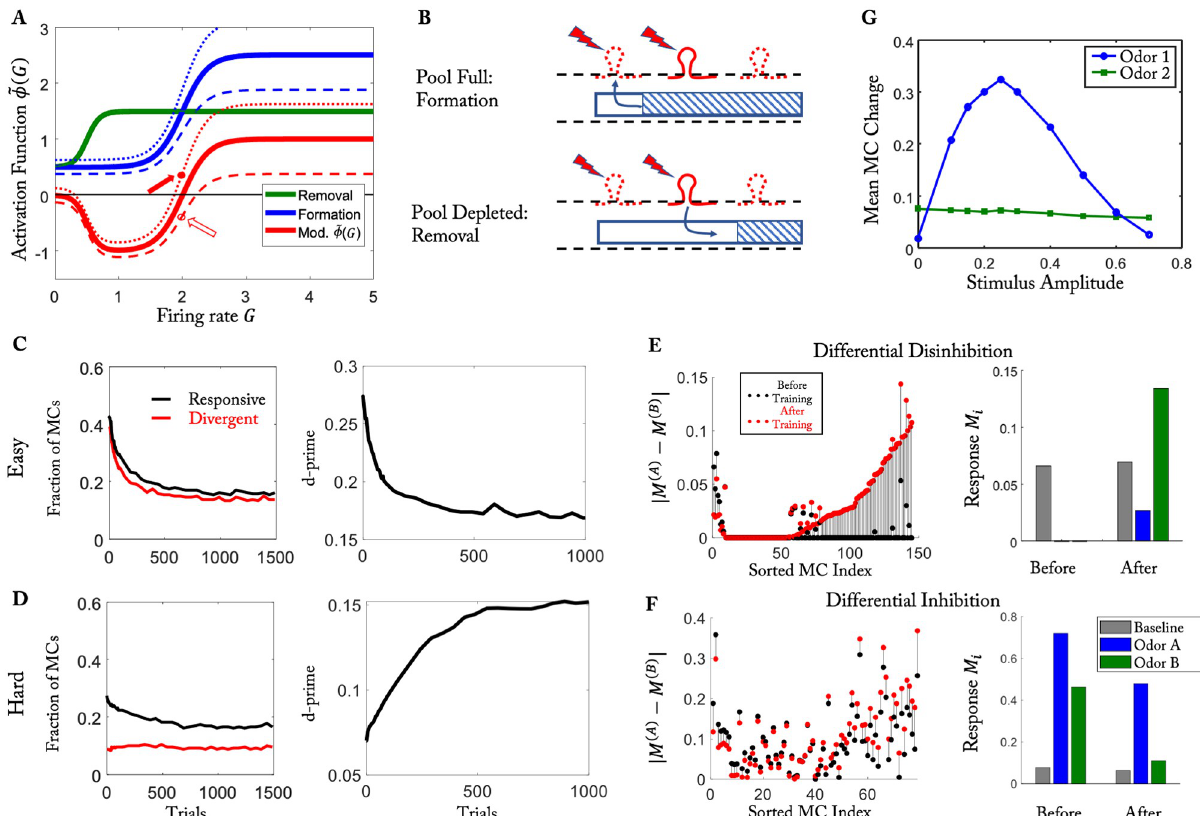
Fig 9. Synaptic competition via a common resource pool. The training protocol is the same protocol as in Fig 2. (A) The modified activation function ~ � ð G Þ (red) is the difference between the formation function (blue) and the removal function (green). P = P 0 (thick), P > P 0 (dotted), P < P 0 (dashed). (B) (Top) For P > P 0 synapses tend to form (solid arrow in (A)). (Bottom) For P < P 0 synapses tend to be removed even though the GC activity is the same (open arrow in (A)). (C) In the easy task, left: Responsive and divergent cells and right: discriminability (cf. Fig 2E and 2F). (D) Same as (C) but for the hard task (cf. Fig 2G and 2H). (E, F) Differential disinhibition and inhibition (cf. Fig 6). (G) Removal of spines for training with intermediate activities leads to an increase in MC activity (cf. Fig